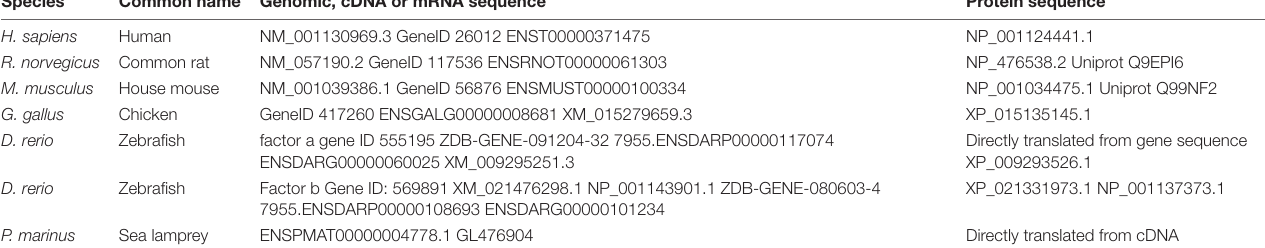
TABLE 1 | Accession numbers of Jacob protein and Jacob/ NSMF gene sequences reviewed for conservation. Species